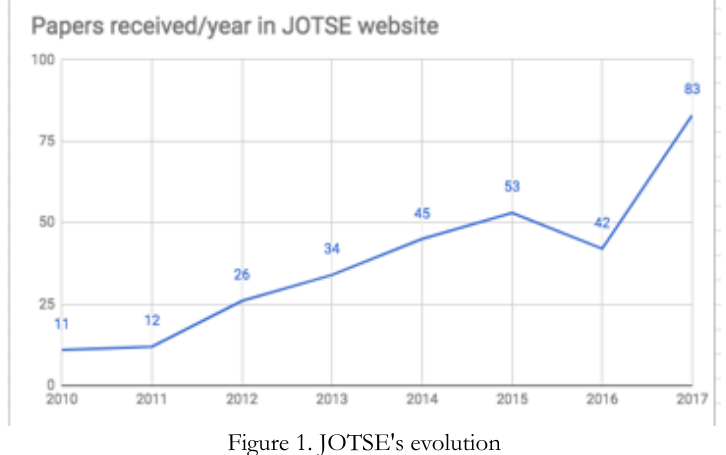
Figure 1. JOTSE's